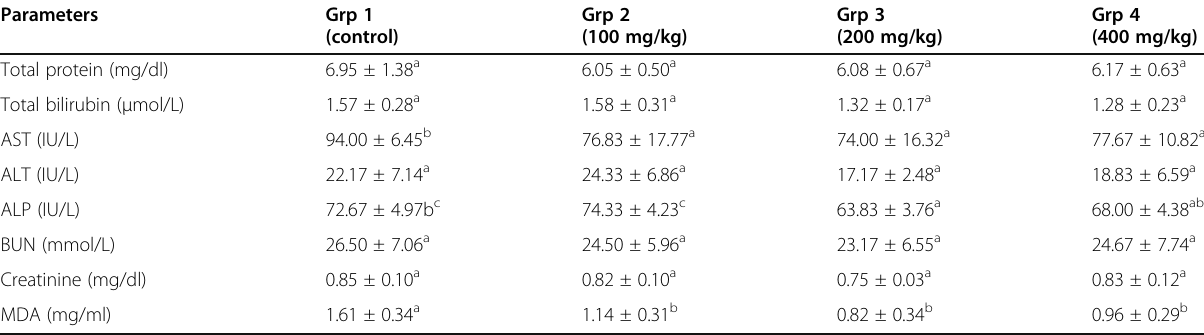
Table 3 Biochemical parameters of rats administered with JTME for 28 days